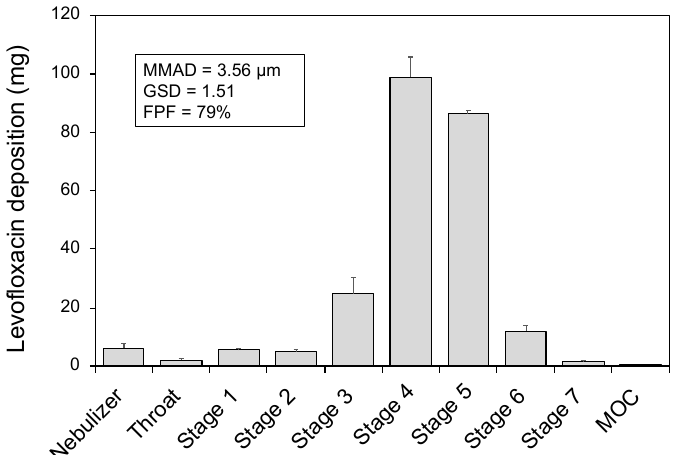
Figure 1. Levofloxacin deposition in components of the in vitro set-up during next-generation cascade impactor experiments. MMAD, mass median aerodynamic diameter; GSD, geometric standard deviation; FPF, fine particle fraction.